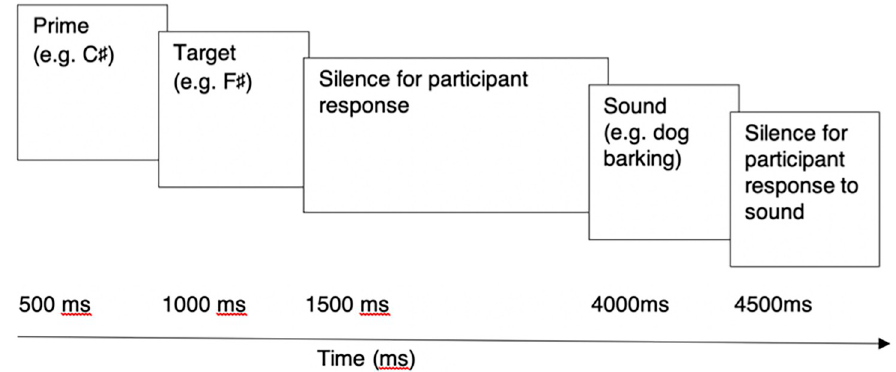
Fig 1. Experimental paradigm for the explicit priming AP task